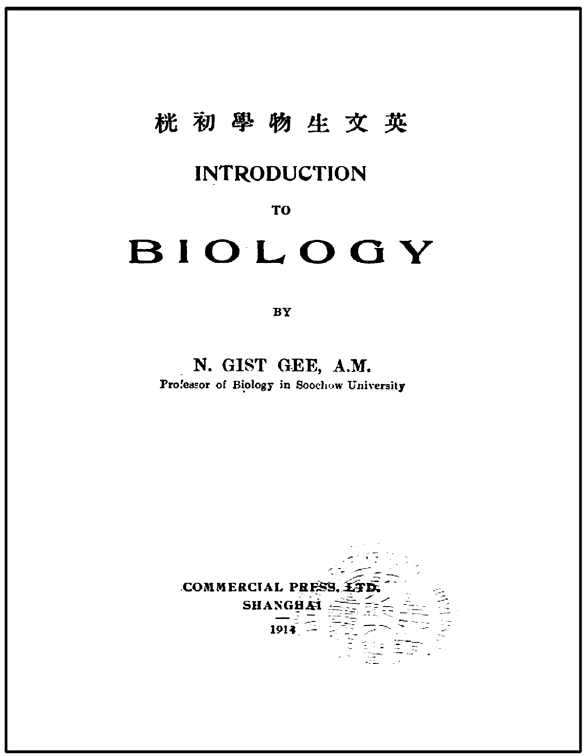
Figure 2. Introduction to Biology, by N. Gist